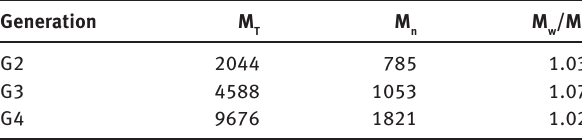
Table 2 Molecular weight and polydispersity of